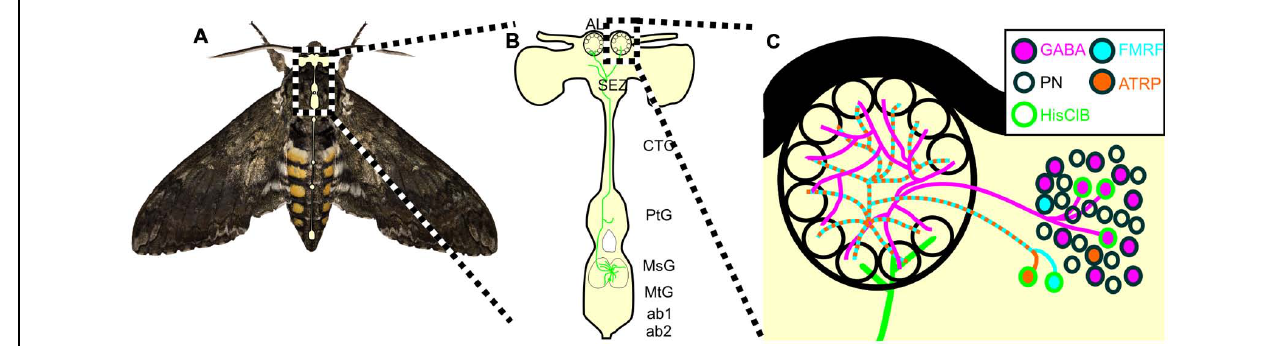
FIGURE 7 | Schematic of the proposed MDHn circuit. (A) Manduca with overlaid nervous system cartoon. (B) Schematic of the MDHn cells from the thoracic ganglia to the AL. Only one cell is shown in detail with processes radiating in the MsG, a small process in the prothoracic ganglion, projecting up the cervicothoracic connective, a branch to the AMMC, and bilateral projections to each AL. (C) MDHn projection entering the ventral AL (green) along with the proposed AL circuitry. For the sake of simplicity, only the processes from MsHisClB-ir expressing neurons (green outline) are shown. MsHisClB-ir GABAergic (pink with green outline) and peptidergic (cyan or orange with green outline for FMRFamide and ATR, respectively) LNs ramify each glomerulus. Other cell types are also present including PNs (open circles), GABAergic LNs (pink circles with black outlines), ATR LNs (orange circles with black outline), and FMRF LNs (blue circles with black outline). AL, antennal lobe; oe, esophageal foramen; SEZ, subesophageal zone; CTC, cervicothoracic connective; PtG, prothoracic ganglion; MsG, mesothoracic ganglion; MtG, metathoracic ganglion; ab1, abdominal ganglion 1; ab2, abdominal ganglion